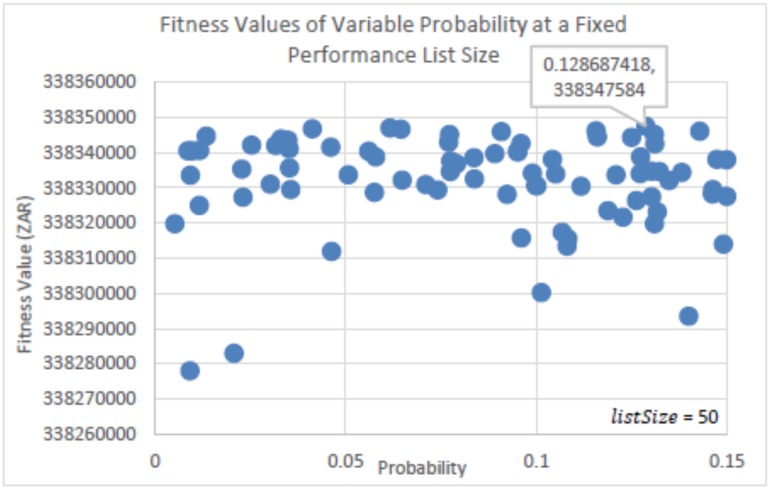
Zoomed in image of Fig 3.